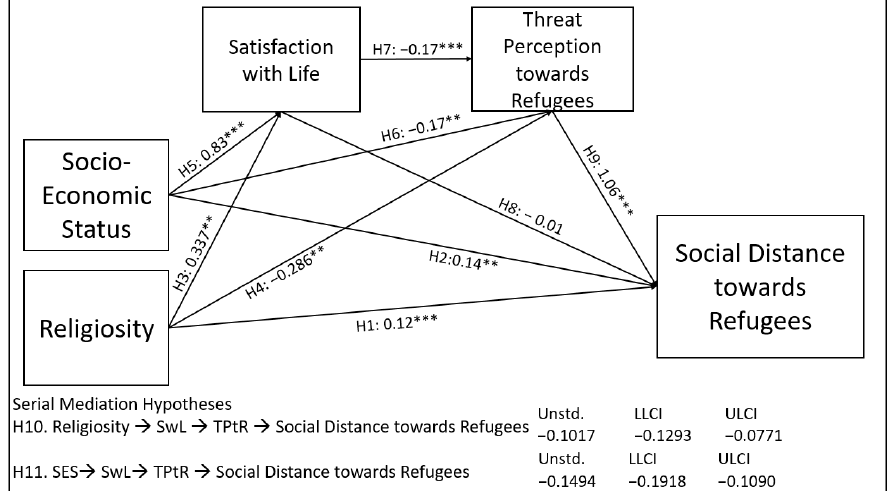
Figure 2. The proposed research model’s findings; ** p < 0.01, *** p < 0.001.